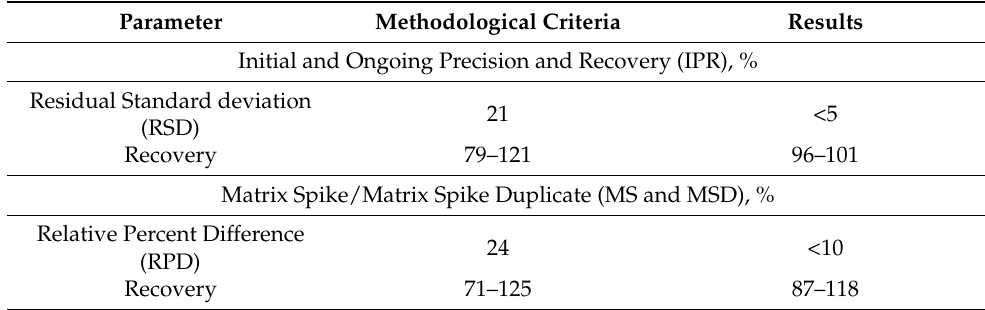
Table 1. QA/QC quality criteria of the US EPA 1631 method. Parameter Methodological Criteria